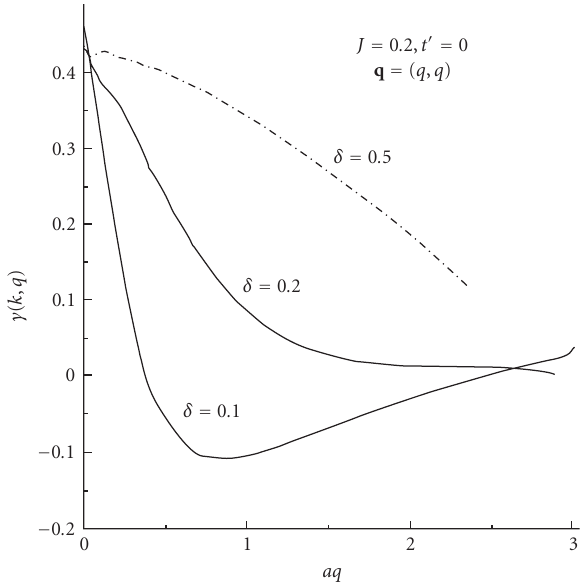
Figure 35: Adiabatic ( ω = 0) vertex function γ ( k F , q ) of the t - J model as a function of the momentum aq with q = ( q , q ) for three di ff erent doping levels δ . From [130].